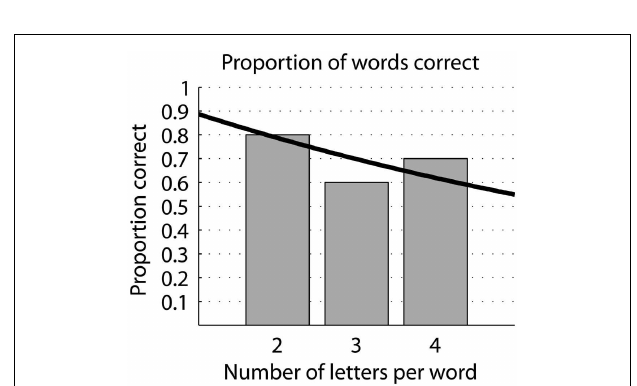
FIGURE 6 | Degree of error in recognizing single letters. (A) The distance in error between the stimulated and perceived letter. Each degree is a perceived dot added, missed, or perceived in a wrong location. Zero degree difference is correct identification. Most errors are a single degree. Theoretically, the maximum error is 6˚. (B) The type of error, an extra perceived dot, a misplaced dot, or a missed dot, as a function of the distance in error.